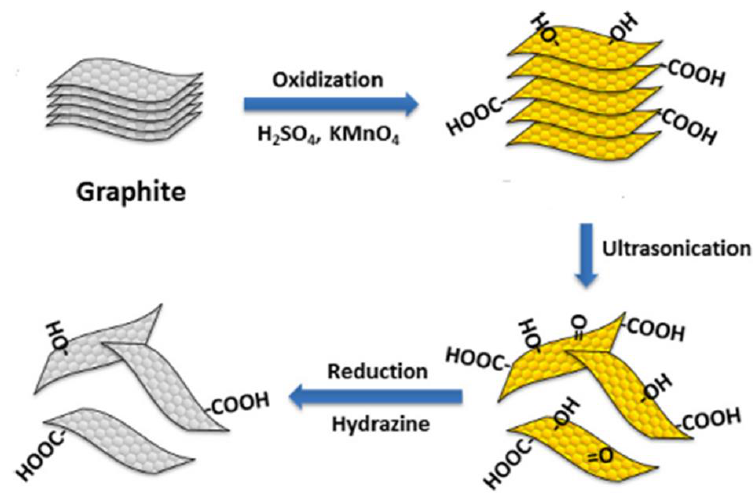
Figure 2. Scheme of a typical procedure for graphene derivatives from graphite as a starting material [33].